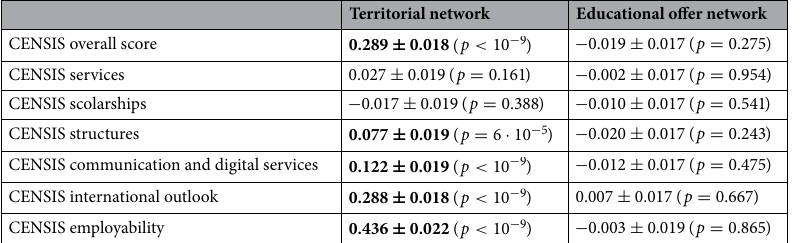
Table 4. Assortativity of the territorial network and the educational offer network of the Italian case study with respect to the following CENSIS rankings: overall , services , scholarships , structures , communication and digital services , international outlook , employability . For each assortativity value, the standard error and p -value, computed according to the Student t -distribution hypothesis, are provided (see “Materials and methods” 2 section for details); significant assortativity values ( p < 10 − ) are highlighted in